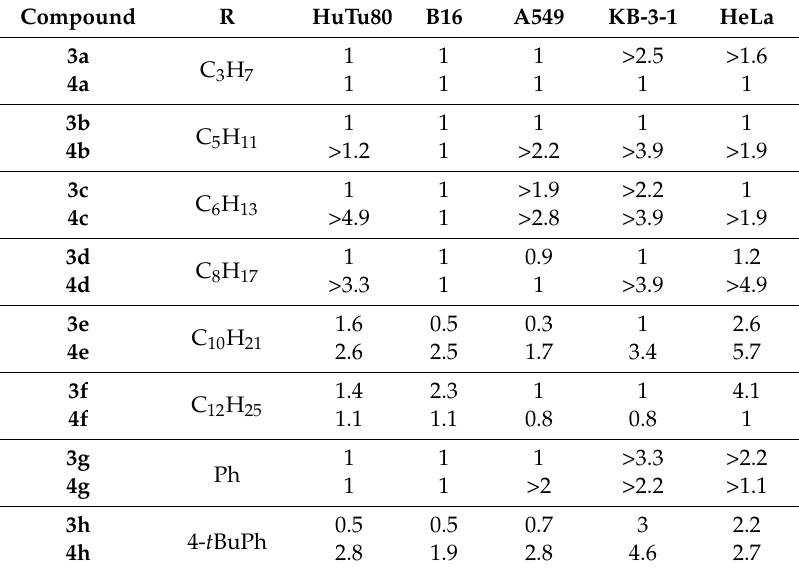
Table 2. Selectivity index of the tested